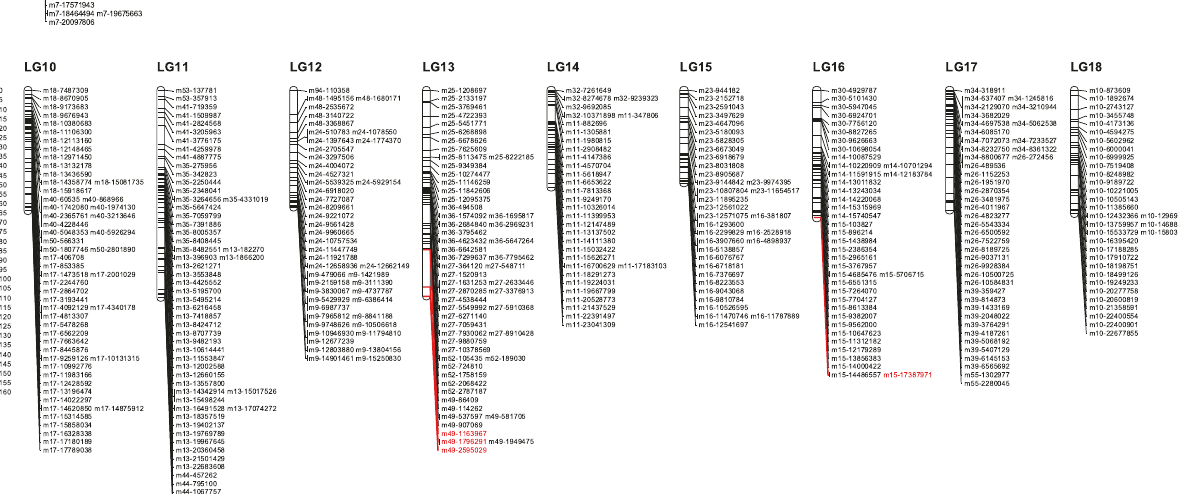
Fig. 3 A genetic linkage map based on a F2 offspring bred from iM line and iBS90. The markers were labeled by the scaffold # followed by the physical position of the SNP. Markers in red represent those markers used for validation by Sanger